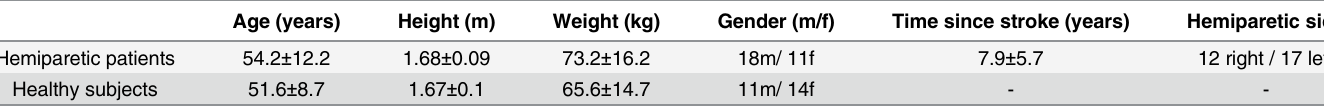
Table 1. Subject